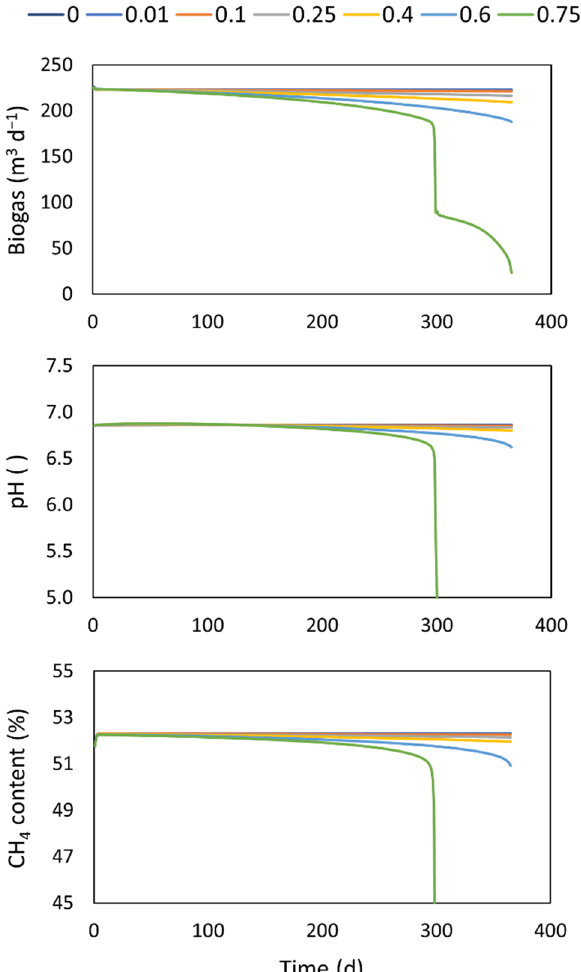
Figure 2. Performance of a digester under different rates of solid material accumulation.